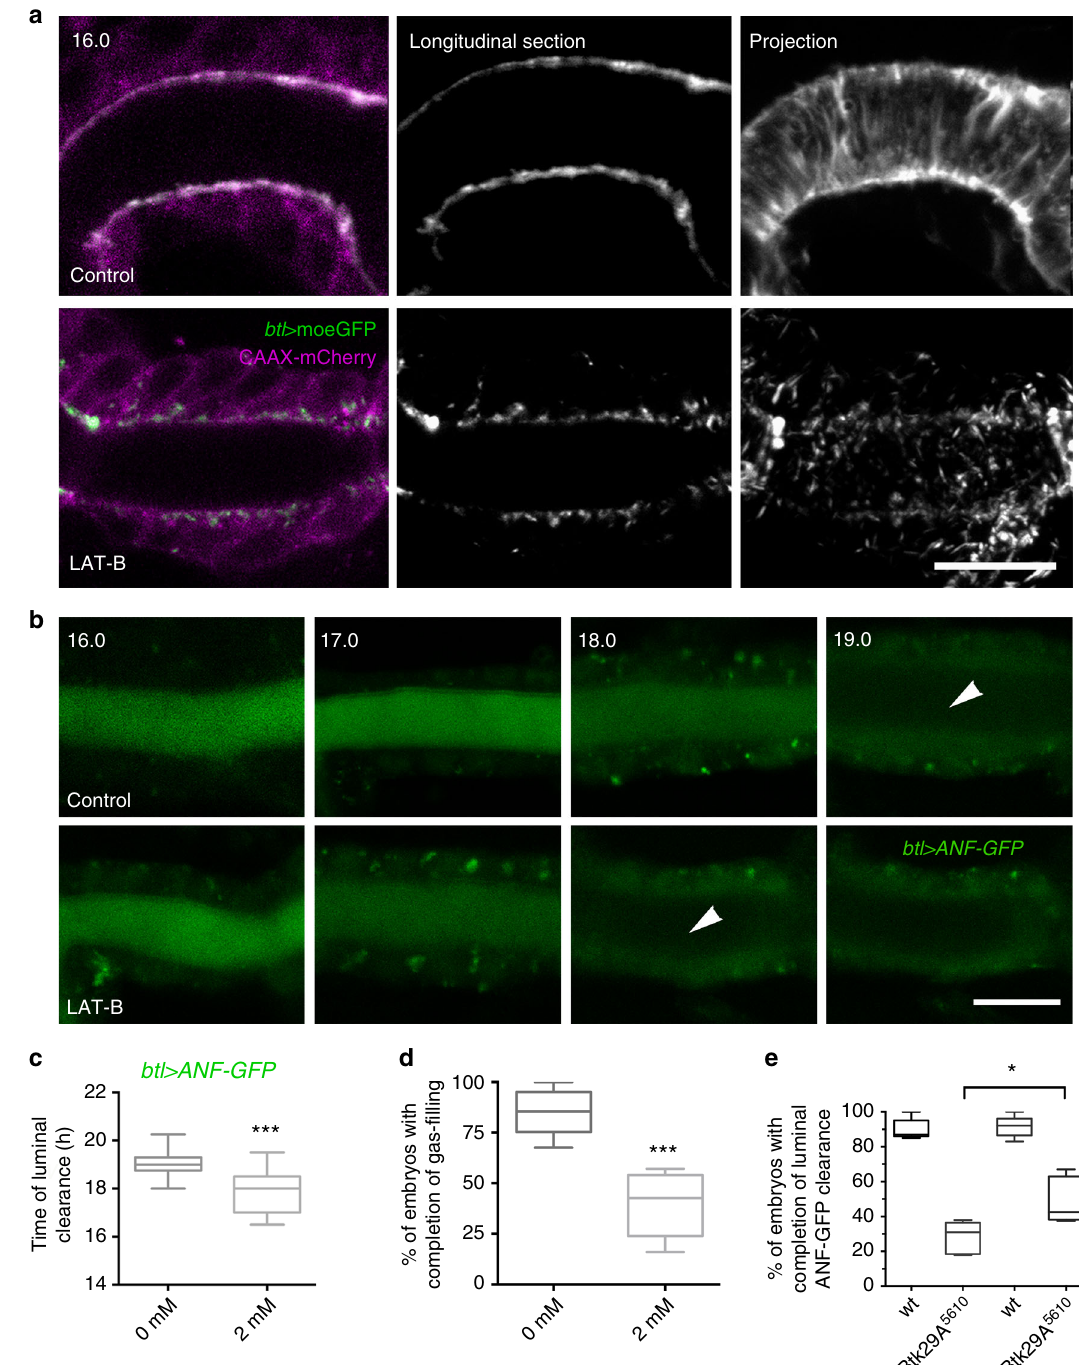
Fig. 6 Chemical disruption of F-actin bundles induces apical endocytosis. a Airyscan confocal micrographs from live recordings showing the dorsal trunk (DT) of dimethyl sulfoxide (DMSO)-treated (control) or 2 mM (LAT-B)-treated wild-type embryos expressing the actin reporter btl>moeGFP (green and grey) and the membrane marker btl>CAAX-mCherry (magenta) in tracheal cells. Left and middle column show longitudinal sections. The right-most column depicts Z -stack projections. b Selected frames from confocal live imaging showing the DT of DMSO-treated (control) and 2 mM LAT-B-treated wild-type embryos expressing btl>ANF-GFP (green). LAT-B-treated embryos complete luminal btl>ANF-GFP clearance earlier than the controls (arrowheads). Arrowheads indicate the cleared tracheal lumen. Time points are hours after egg laying. c , d Plots showing the average time (hours) of luminal ANF-GFP clearance ( c ) or gas fi lling ( d ) in DMSO-treated (control) ( n = 41) and LAT-B-treated (2 mM) wild-type embryos ( n = 46). LAT-B-treated embryos clear luminal ANF-GFP signi fi cantly earlier. *** P < 0.001 denotes statistical signi fi cance (unpaired two tailed t tests). e Plots depicting the percentage of DMSO treated (control) wild-type ( n = 50) and Btk29A 5610 ( n = 48) embryos as well as LAT-B-treated wild-type ( n = 61) and Btk29A 5610 embryos ( n = 72) that complete luminal btl>ANF-GFP clearance. * P < 0.021 (unpaired two tailed t test). The boxplots show the median (internal line) and the range of the data is from 25th to 75th percentile. The bars present maxima and minima values. Scale bars, 10 μ